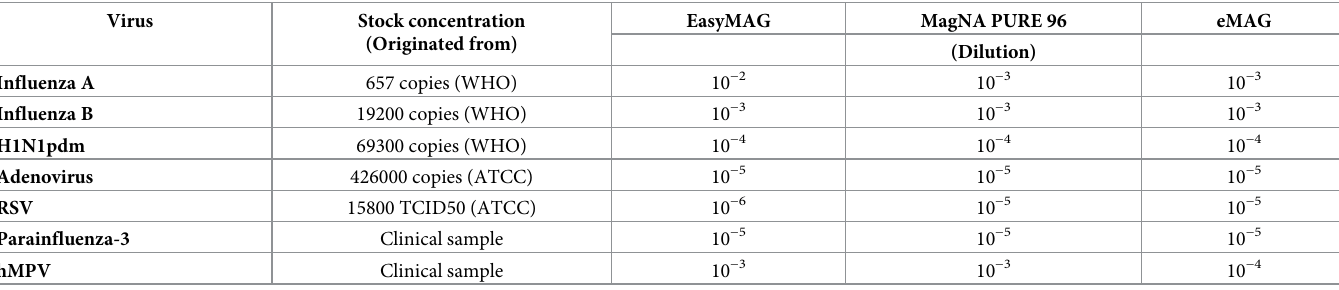
Table 3. Limit of detection (LOD) for each respiratory virus in all platforms. Virus Stock concentration EasyMAG MagNA PURE 96 eMAG (Originated from)